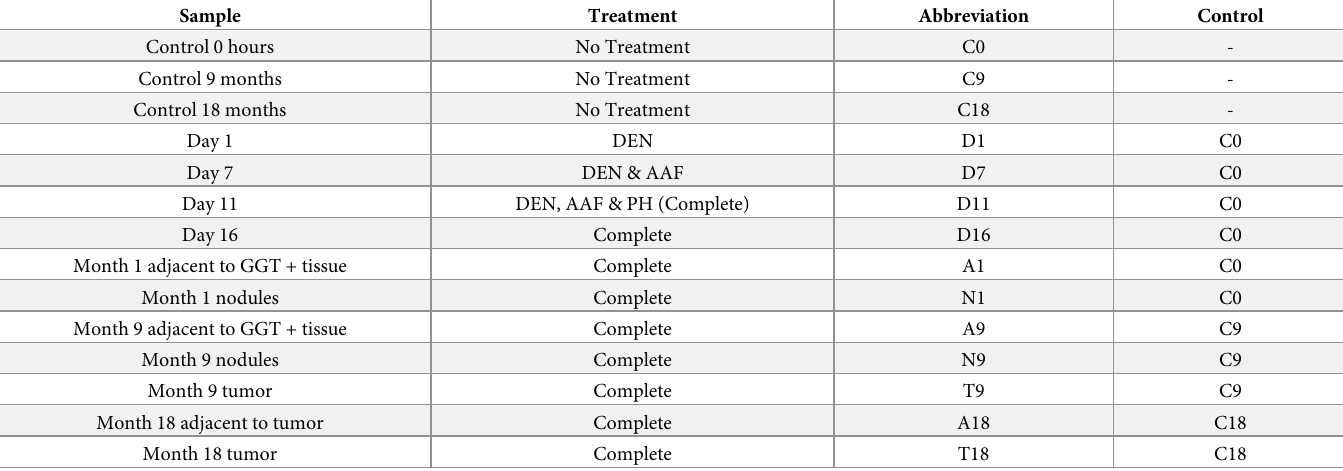
Table 1. Stages of HCC development and tissues sampled. The treatment to which the samples were subjected is shown. DEN, diethylnitrosamine; AAF, 2-acetylamino- fluorene; PH, partial hepatectomy. The abbreviations used in the manuscript are shown in the third column. The controls used for each sample are shown in the fourth column.